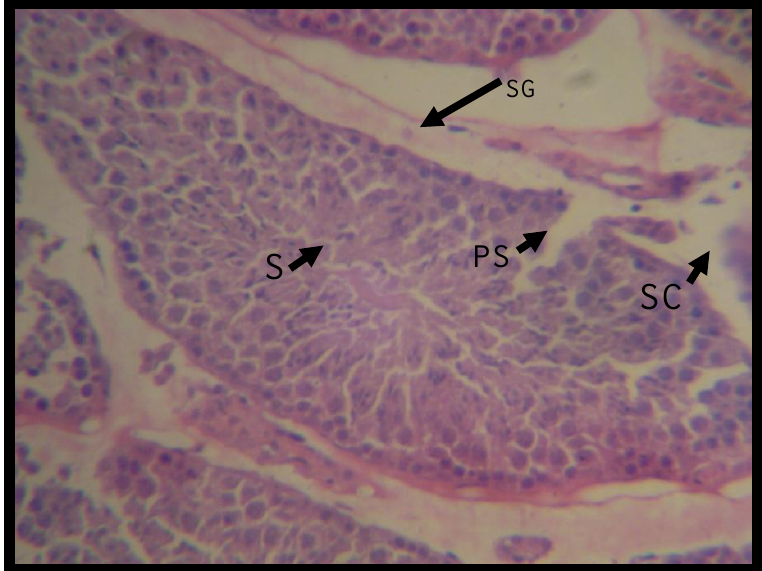
Fig. 1: Histopathological section of testis of the control male Mice shows spermatogonium (SG),primary spermatocyte (PS),Sertoli cells(SC),Spermatid (S) , (H & E 40X).